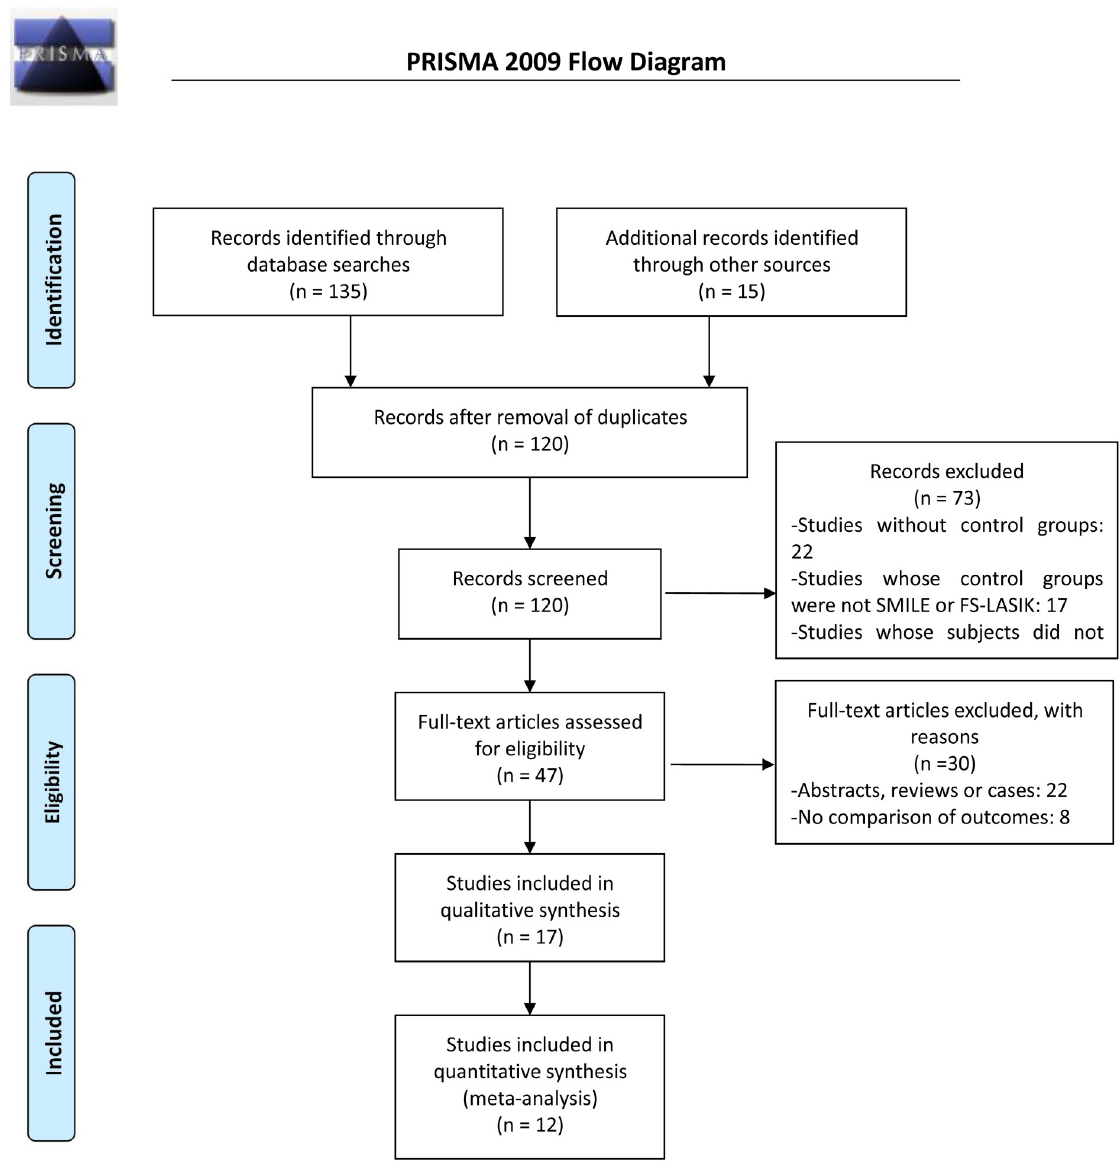
Fig 1. Flow diagram of the literature